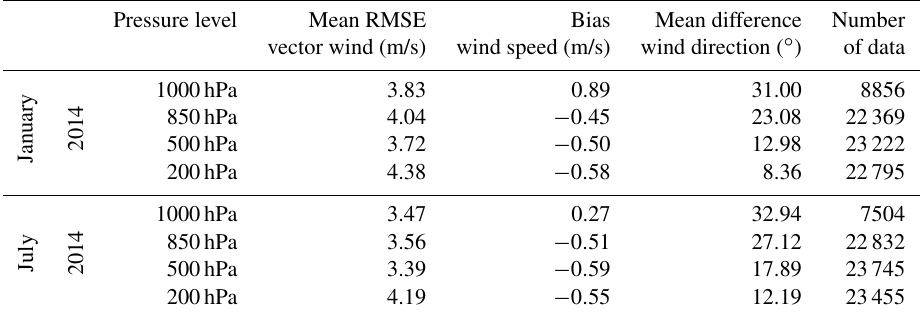
Table 2. Evaluation of MPAS-A simulated horizontal wind using NOAA Integrated Global Radiosonde Archive (IGRA) radiosonde data. Radiosonde data from 457 stations over the globe are used for the evaluation. Wind speed and direction are compared at 00:00 and 12:00UTC at four pressure levels (1000, 850, 500, and 200hPa) for each day of the MPAS-A simulation. The number of data samples ( N ) is smaller at 1000hPa because some stations are located above that pressure level.